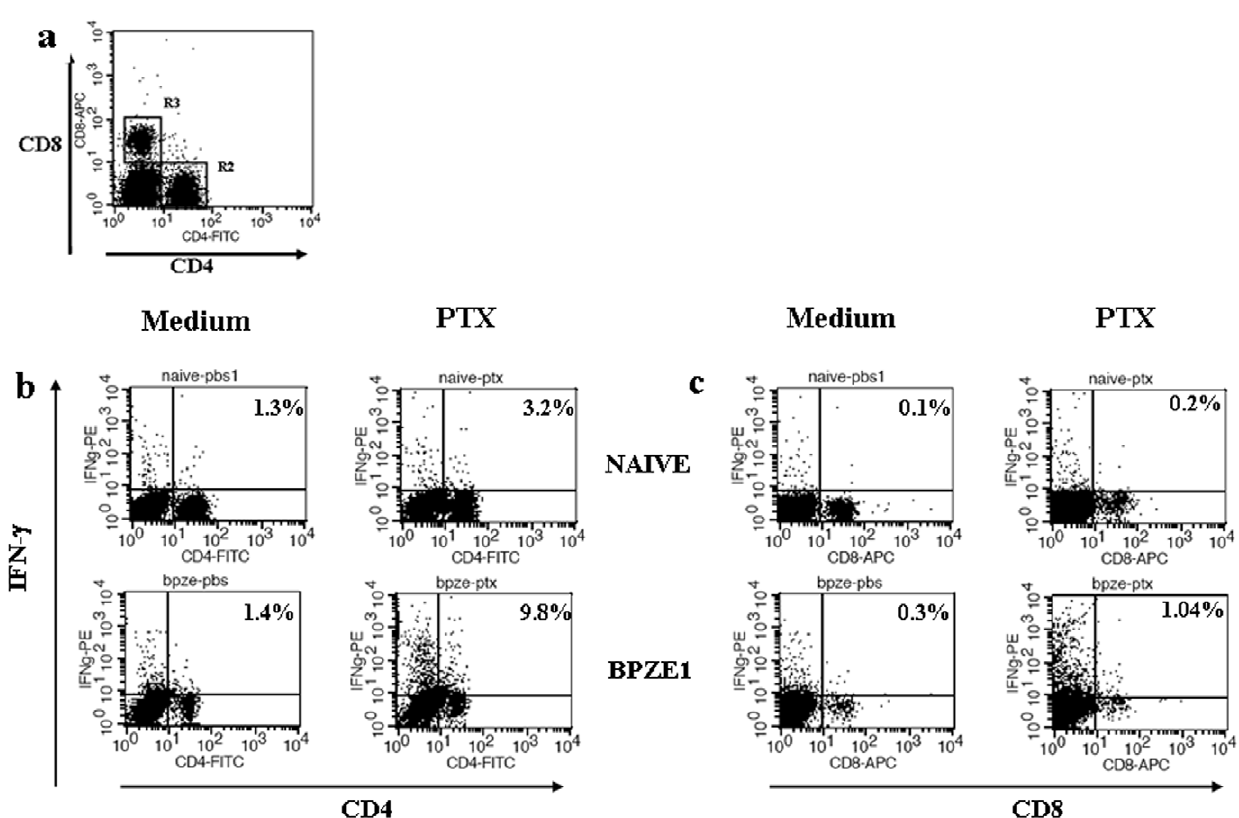
Figure 3. CD4 + T phenotype of IFN- c -producing T cells following BPZE1 administration. BALB/c mice were left untreated (Naı¨ve) or immunized intranasally with 10 6 CFU of B. pertussis BPZE1 (BPZE1). Eight weeks later, the mice were sacrificed and spleens of three individual mice per group were pooled and homogenized to obtain single-cell suspensions. 2.5 6 10 6 cells were cultured in triplicate overnight in the presence of 10 m g/ ml PTX (PTX) or left unstimulated (Medium). Spleen-derived T cells were then labelled for surface expression of CD4 and CD8 ( a ), and intracellular IFN- c expression by CD4 + ( b ) and CD8 + ( c ) T cells was assessed by flow cytometry. The results shown are representative of three independent experiments.